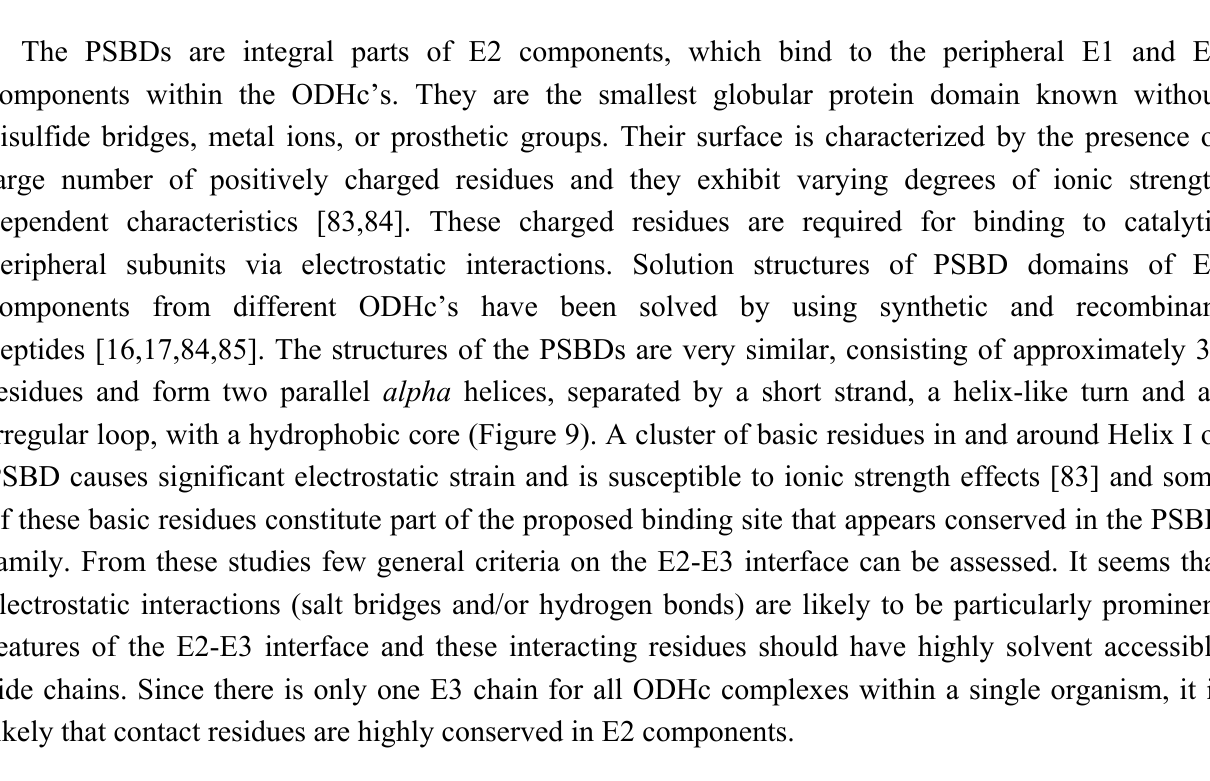
Figure 9. Overlaid structures of PSBD from OGDHc complex of E. coli (Red; PDB Id:1BBL) ( 16 ) and PDHc complex of Bacillus stearothermophilus (Cyan; PDB Id:1W3D) [86] and peripheral-subunit from mesophilic, thermophilic and hyperthermophilic bacteria fold(Blue; PDB Id:1W4H) [84]. The image was created using the program